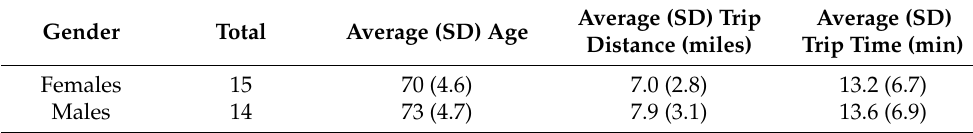
Table 2. Mean and standard deviation (SD) of demographic data ( n = 29) broken down by gender.